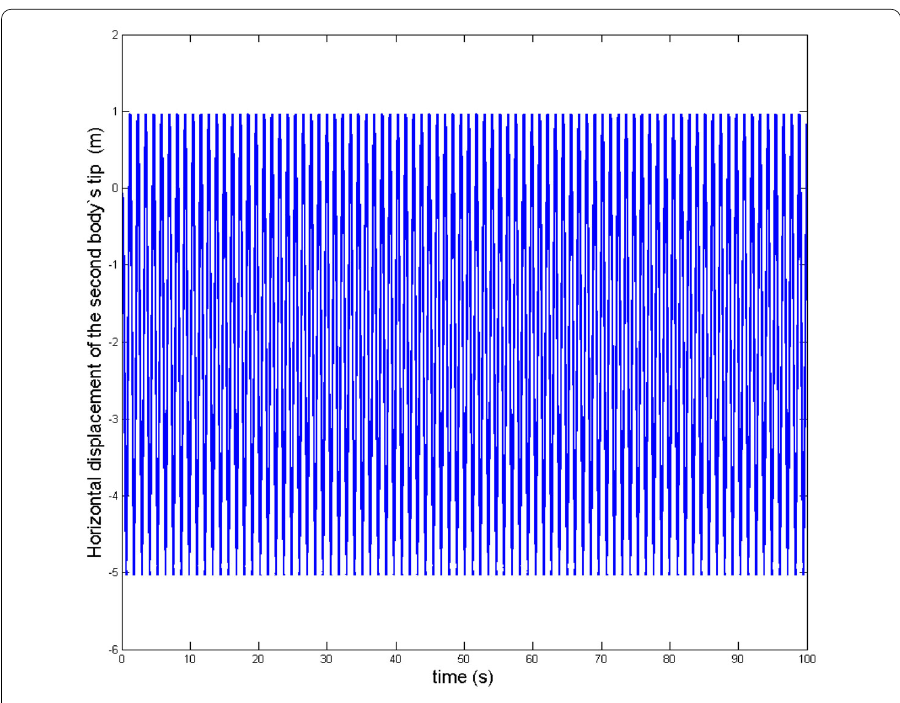
Fig. 31 Horizontal displacement of the slider